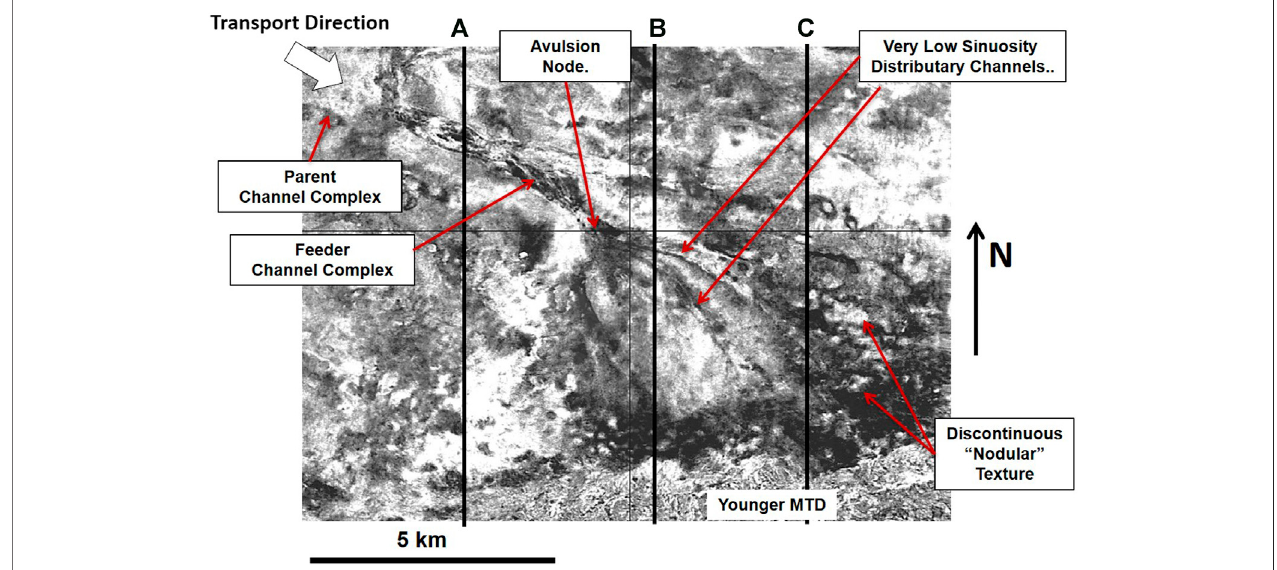
FIGURE 8 | A Root Mean Squared (RMS) amplitude extraction of LE3 from a 3D re fl ection seismic volume. The image is horizon referenced and derived from the interval0 – 50 msabovethebaseofthelobatedeposit(purplehorizonin Figure9 ).HighRMSvaluesaredisplayedaswhitecolor.Sedimenttransportisfromnorthwestto southeast.Thelocationsofseismiccrosssectionsin Figure9 areindicatedbyverticallineslabeled (A) , (B) and (C) .Modi fi edfromPosamentieretal.(2000),Fowleretal. (2001), Posamentier and Kolla (2003), Saller et al. (2003), Saller et al. (2004), Ruzuar et al. (2005), Saller et al. (2008), and Saller et al. (2010).